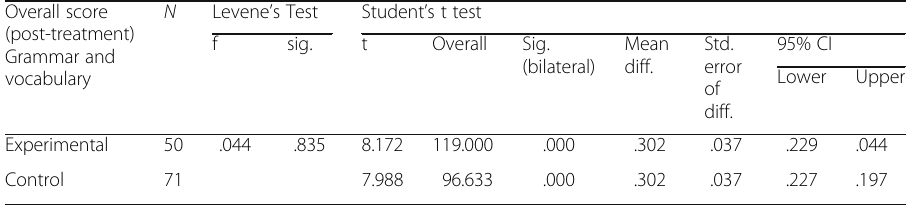
Table 10 Comparative analysis of the mean level of progress in grammar and vocabulary (post-